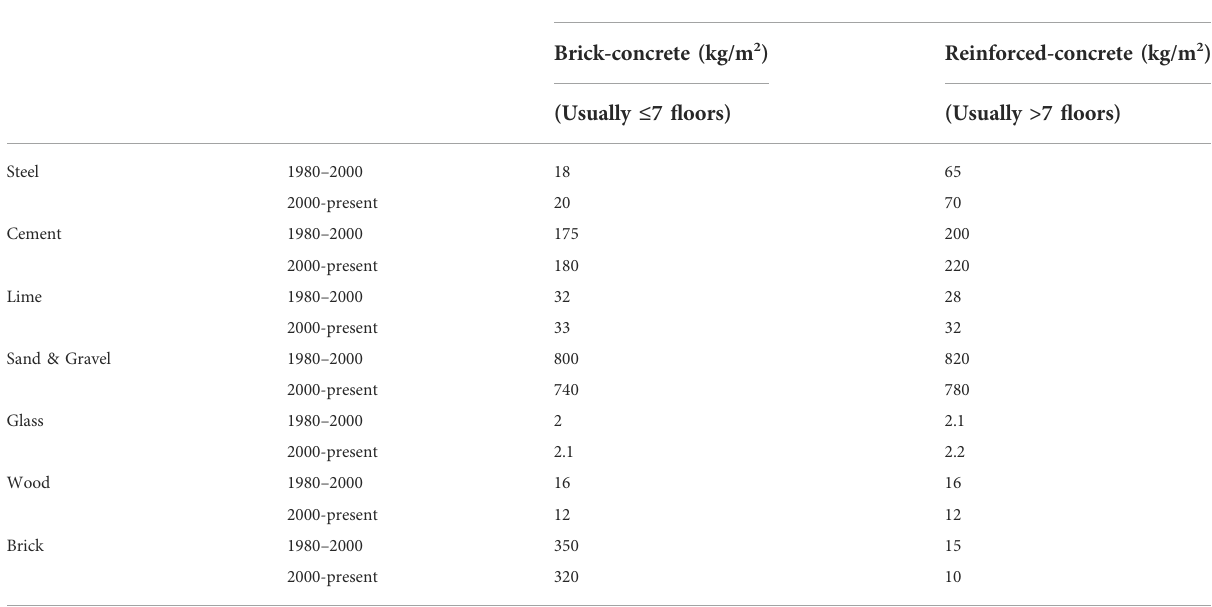
TABLE 2 Material intensity (MI) for building in Shenzhen, China. Material